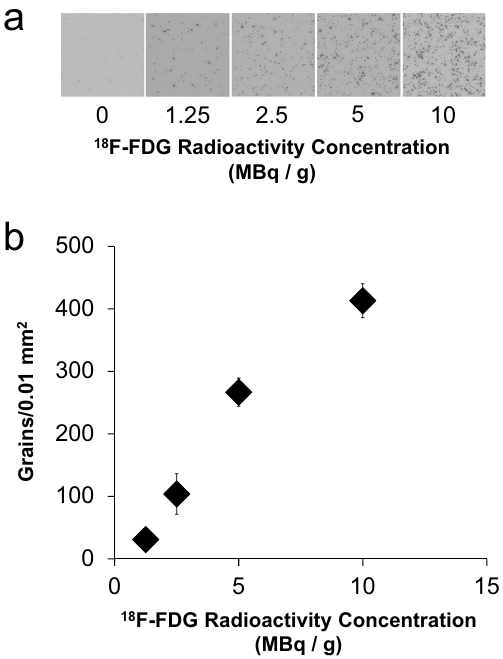
Figure 2. The quantitative radioactive range of micro-autoradiography. ( a ) Micro-autoradiographs of various concentrations of 18 F-FDG-containing samples sliced to 10 μm thickness. ( b ) Scatter plot of grain counts visualized at each concentration of micro-autoradiography. (n = 4, mean ±